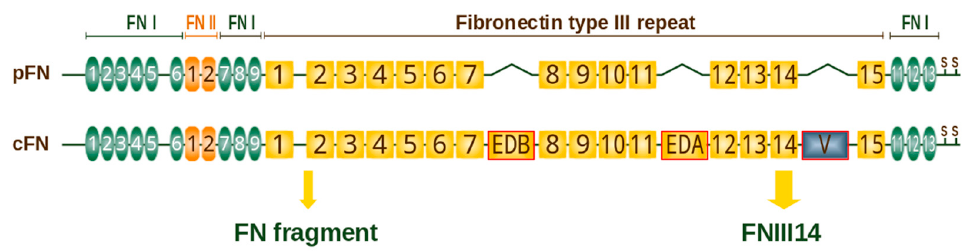
Figure 3. Domain structure of human fibronectin (based on SMART-tool [176] and review [177]). Each monomer contains three types of repeats: fibronectin type I (green ovals), type II (orange) and type III (gold rectangles). One or both of the FN type III modules (ED-A or ED-B) may be present in cellular fibronectin (cFN) but never in plasma fibronectin (pFN). A “variable” V or IIICS region is located between FNIII14 and FNIII15 and spliced out in ~50% subunits of pFN [178]. Two subunits are linked by a pair of C-terminal disulfide bonds to form a protein dimer. FNIII14 and “FN fragment” are proteolytic bioactive fragments derived from fibronectin.